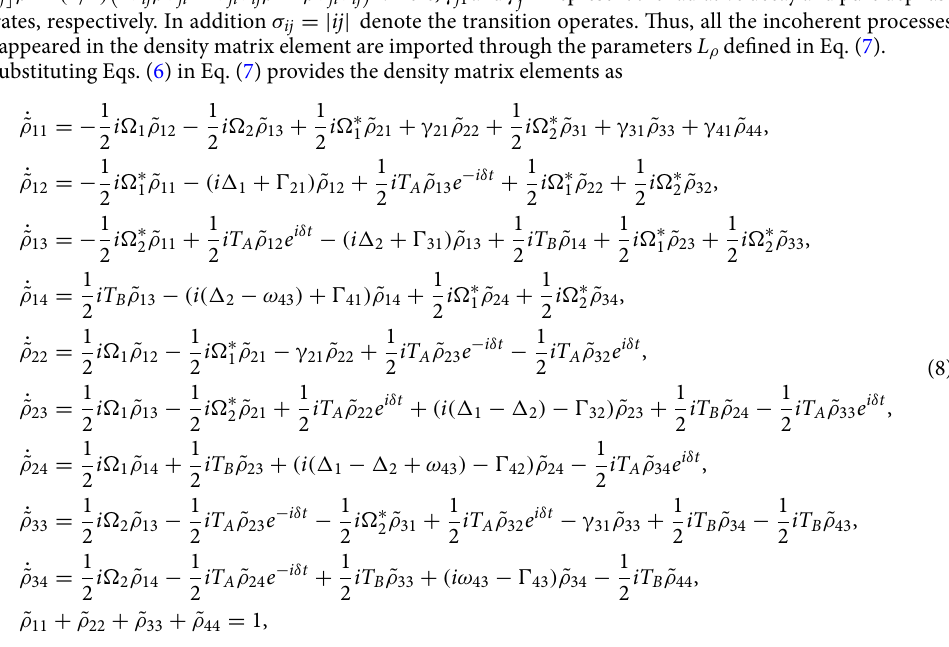
Here (cid:31) ω i is the energy of level The density matrix elements in an arbitrary multilevel QDs system can be obtained using the Liouville equa- tion as